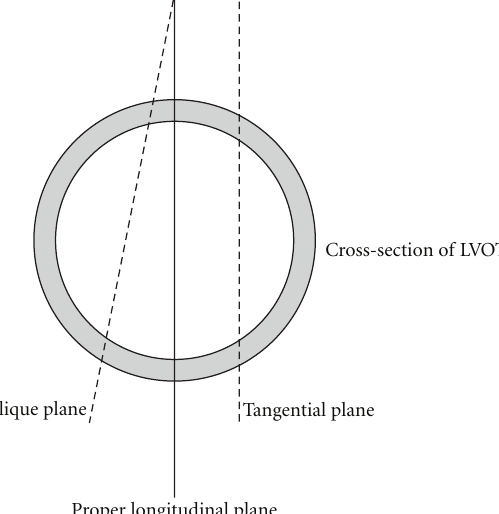
Figure 2: Schematic diagram showing proper and improper ul- trasound longitudinal planes in measuring left ventricular outflow tract (LVOT) diameter. Oblique plane is resulted from a tilted angle from the proper plane, while a parallel shift in ultrasound plane results in a tangential planes. Both oblique and tangential planes give rise to underestimation of LVOT diameter. The same is true for measuring inferior vena cava diameter.